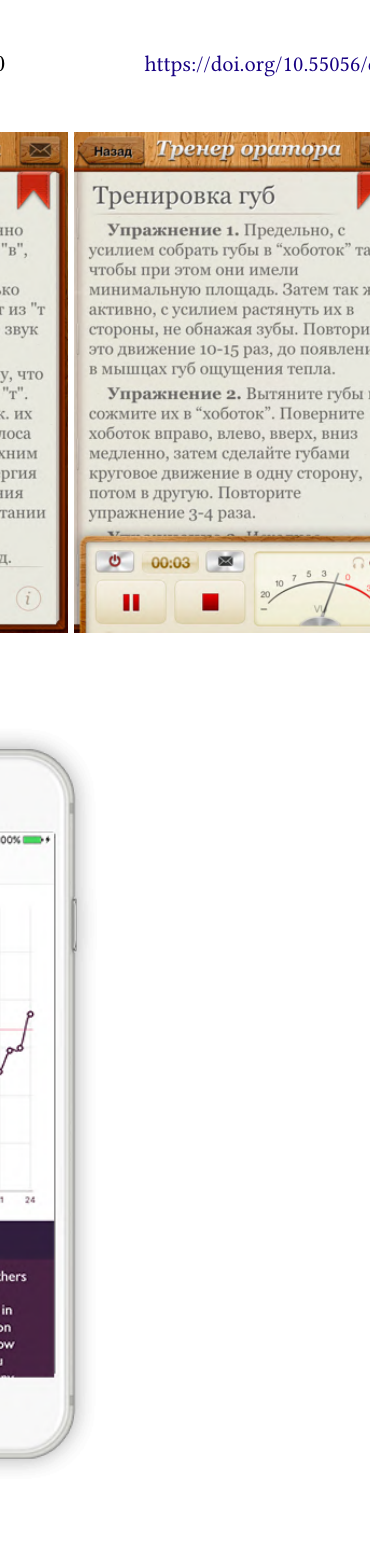
Figure 7: Ummo App.